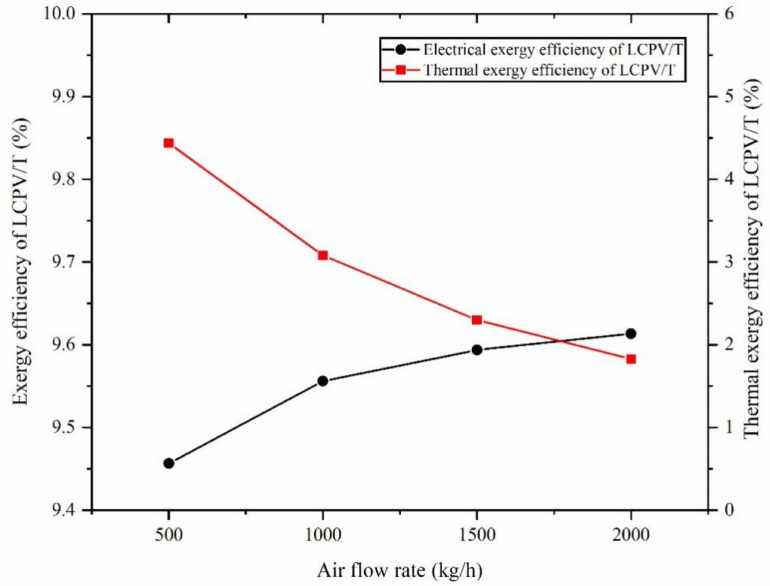
Figure 21. Electrical exergy efficiency and thermal exergy efficiency of the LCPV/T under variable air flow